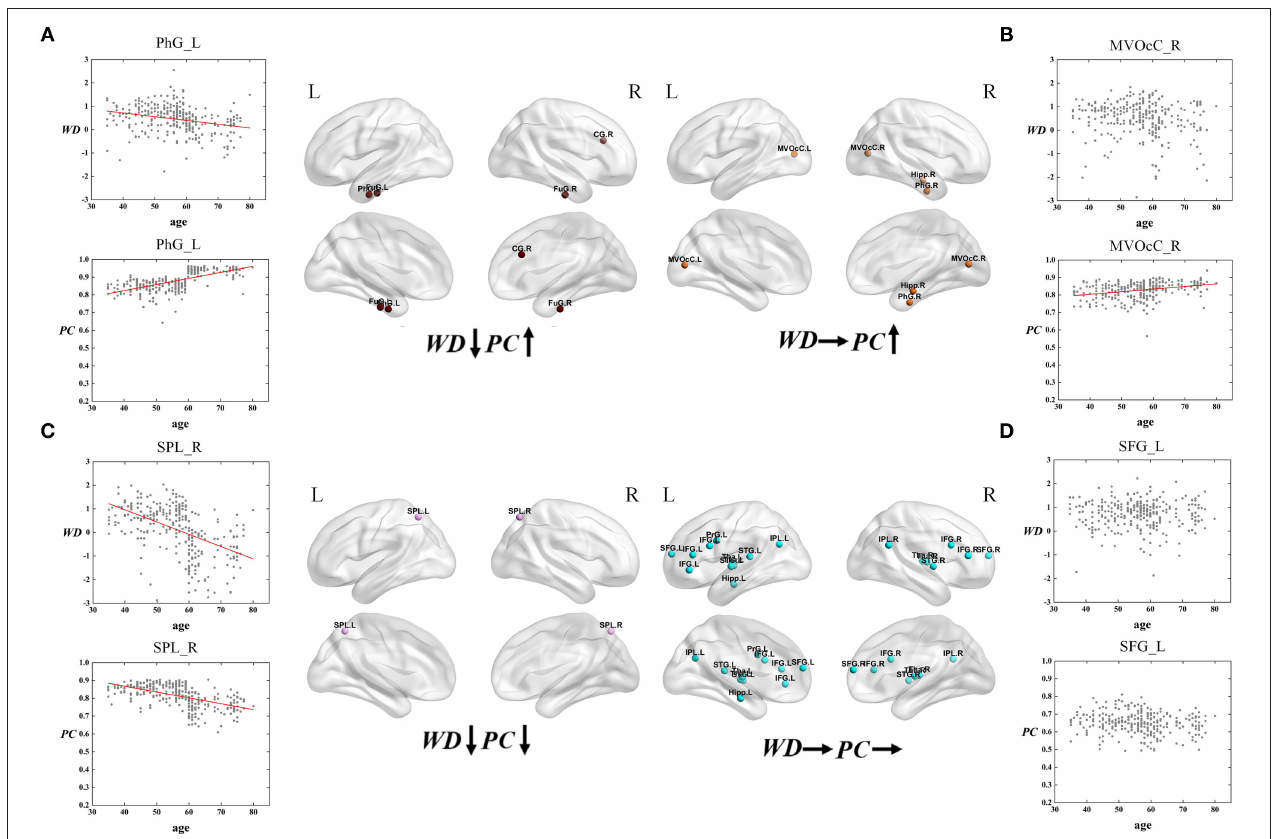
FIGURE 7 | The spatial distributions of hubs at Middle - Old age stage with (A) WD has a negative correlation with age but PC has a positive correlation with age; (B) only PC has a positive correlation with age; (C) both WD and PC have a negative correlation with age; (D) both WD and PC have no correlation with age. Red lines fit the curve with statistically significant